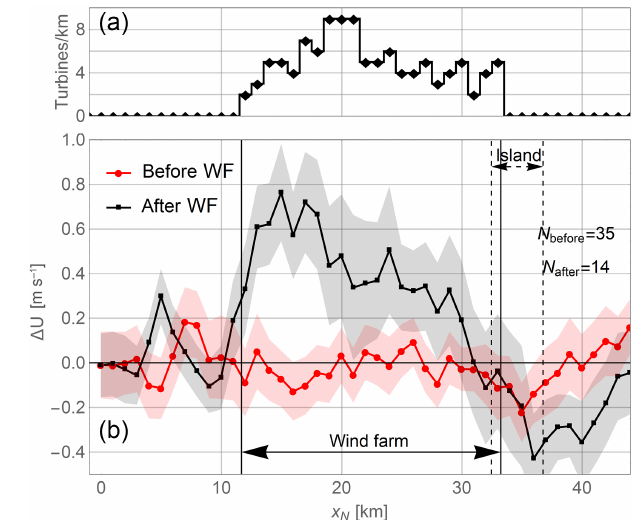
Figure 9. (a) Density of turbines per unit kilometre between the transects. (b) Mean difference between wind speeds on the upstream and downstream transects before and after construction of the An- holt wind farm. Vertical lines indicate the position of the wind farm and dashed lines the position of the island Anholt to the east. The shaded area represents one standard error around the